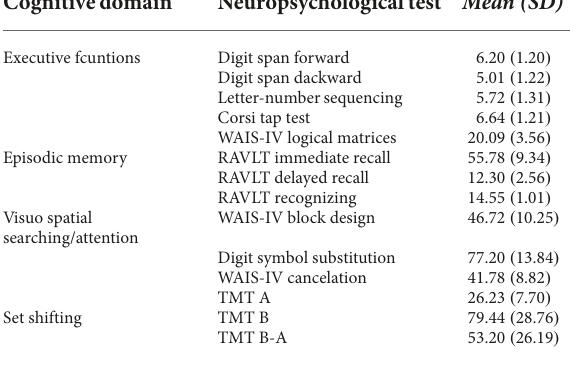
TABLE 2 Results of formal neuropsychological testing of participants and principal components structure.